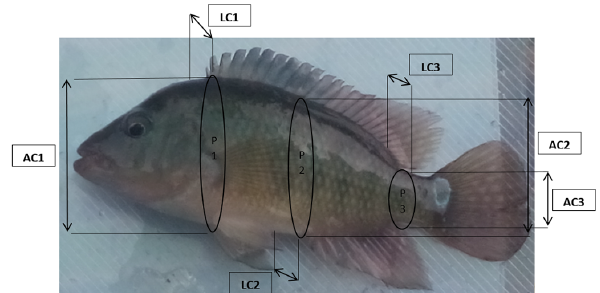
Figure 2. The morphometric measurements registered in each anal- ysed organism (source: own elaboration). AC1: body depth at the first ray of the dorsal fin; AC2: body depth at the level of the first ray of the anal fin; AC3: body depth at the level of the first radius of the caudal fin; P1: body perimeter of the body at the level of the first ray of the dorsal fin; P2: body perimeter at the level of the first ra- dius of the anal fin; P3: body perimeter at the level of the last ray of the dorsal fin; LC1: head width; LC2: trunk width; LC3: tail